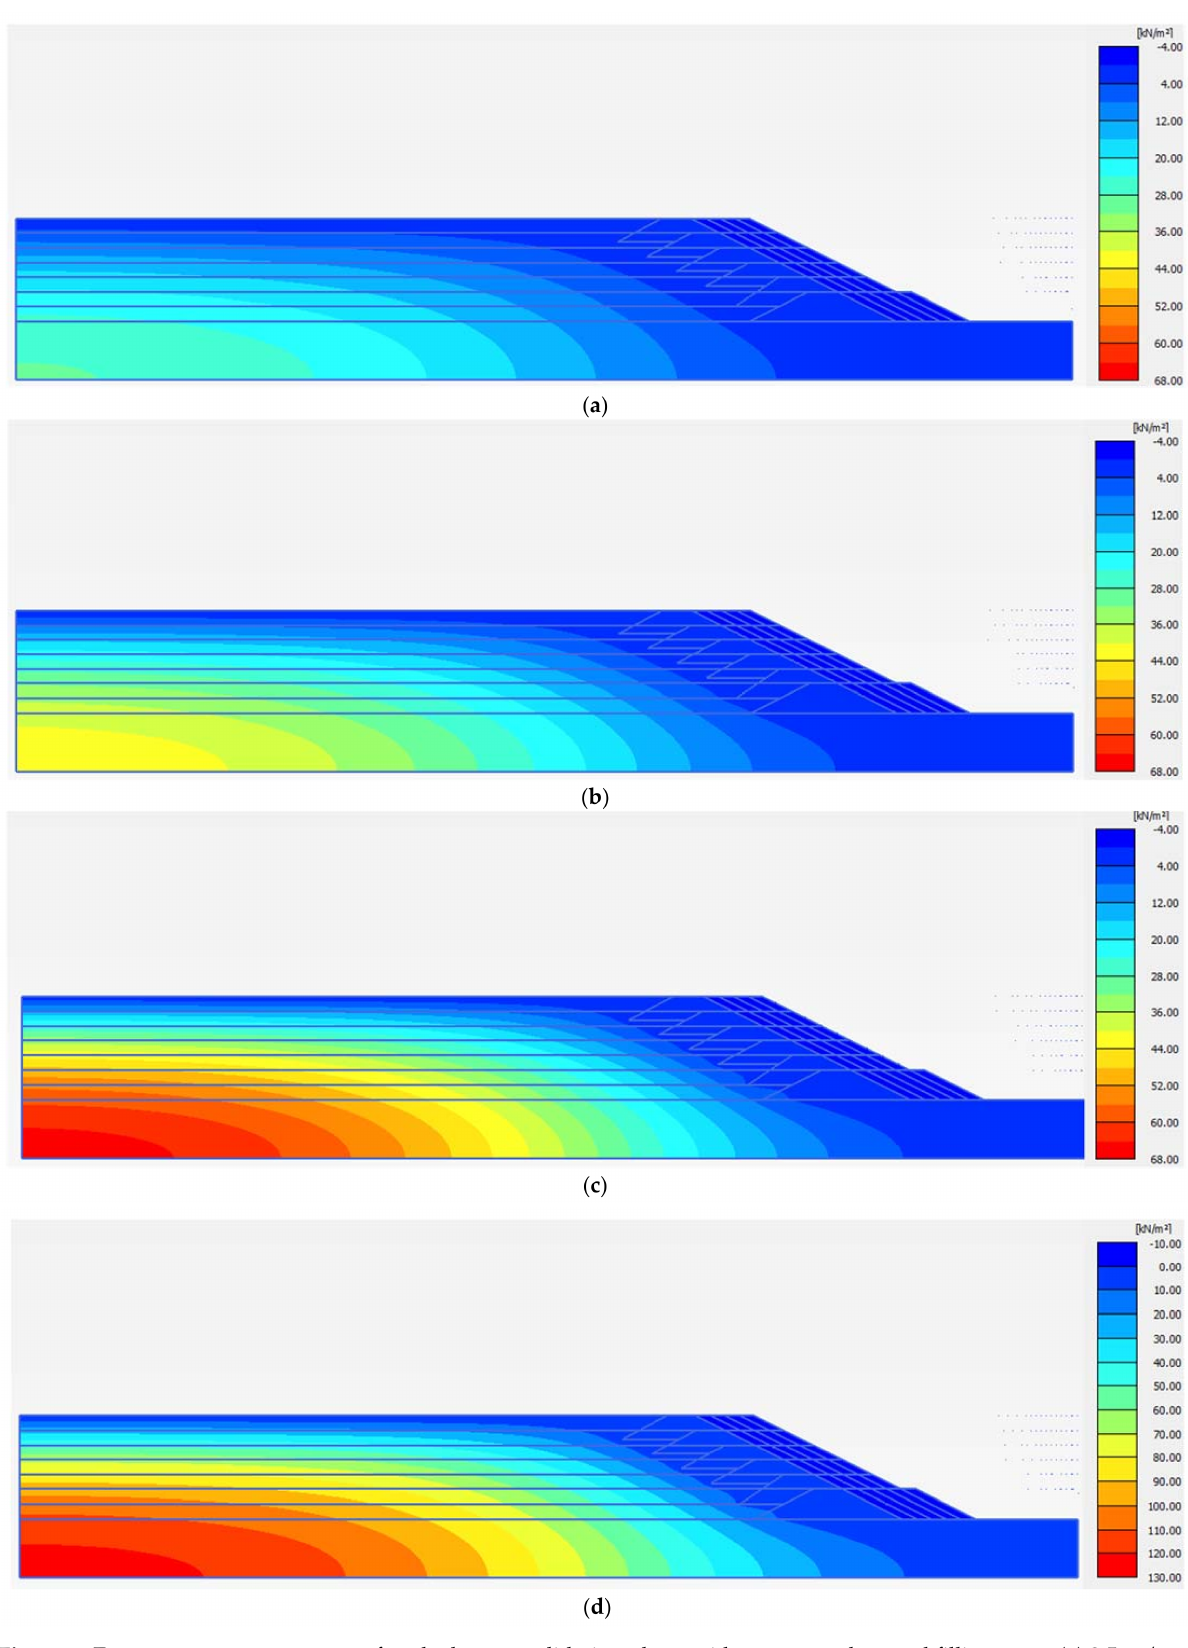
Figure 9. Excess pore water pressure after the last consolidation phase with respect to the pond filling rates: ( a ) 2.5